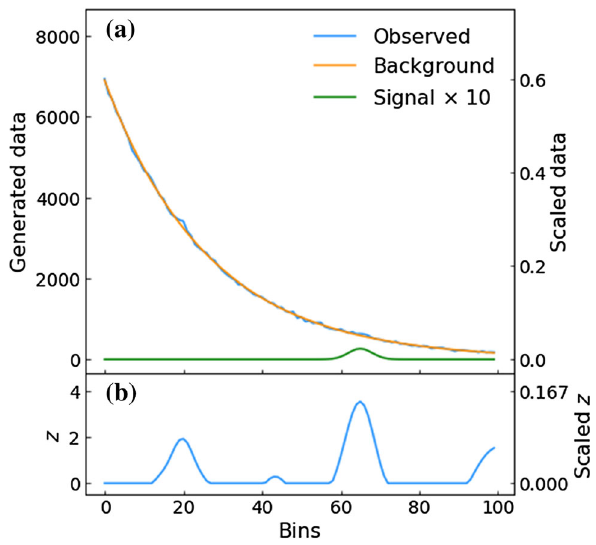
Fig. 1 Illustration of the sample generation procedure. a A smoothly decaying background curve (orange) is generated over 100 bins. Each bin is assigned a Poisson fluctuation. A signal with a significance rel- ative to the fluctuated background (green) is added to it, producing the observed data (blue). b The corresponding significance distribution, z , is calculated analytically. The left and right axes in both panels show the non-scaled and scaled distributions,